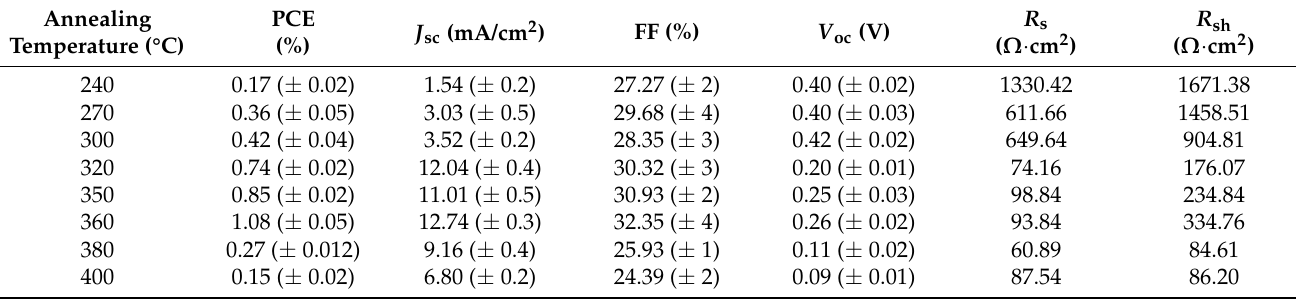
Atomic for microscopy (AFM) images of devices. Figure S4. The microscopy image of a NC solar cell (one single substrate containing 5 devices with active areas of 0.16cm²).